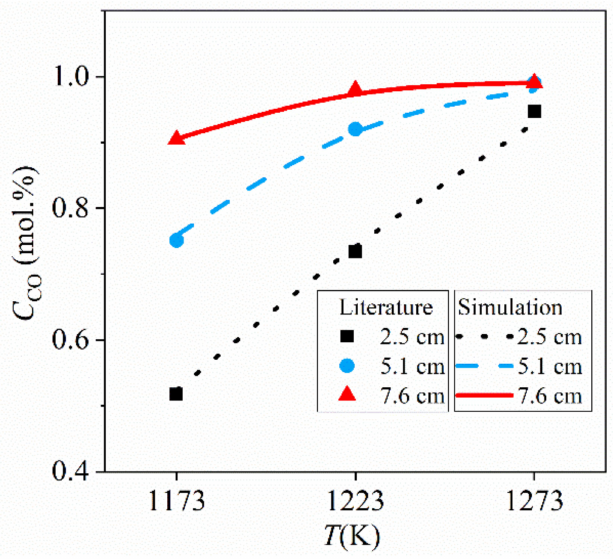
Figure 2. Fluidized bed gasifier with different carbon